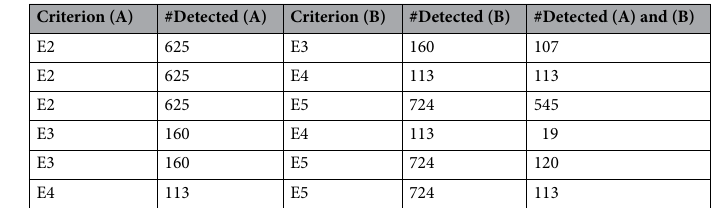
Table 4. Pairwise comparison by criterion of detected bound